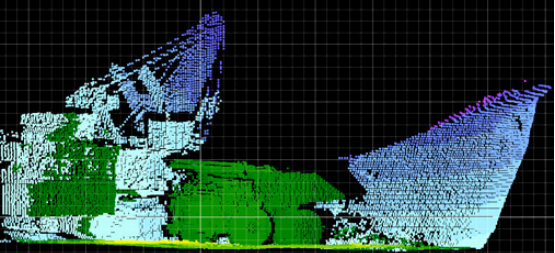
Figure 6: Imaging with OPAL lidar